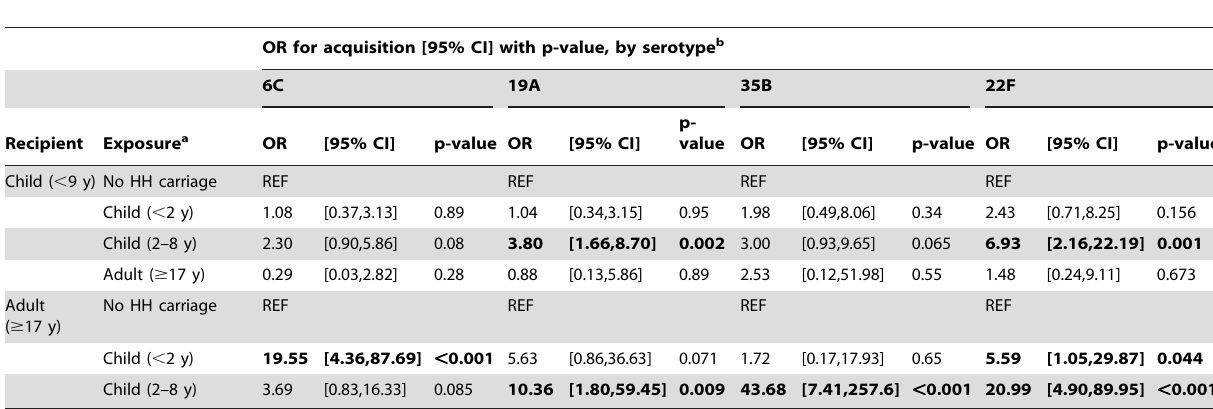
Table 4. Intra-household pneumococcal transmission (multilevel logistic